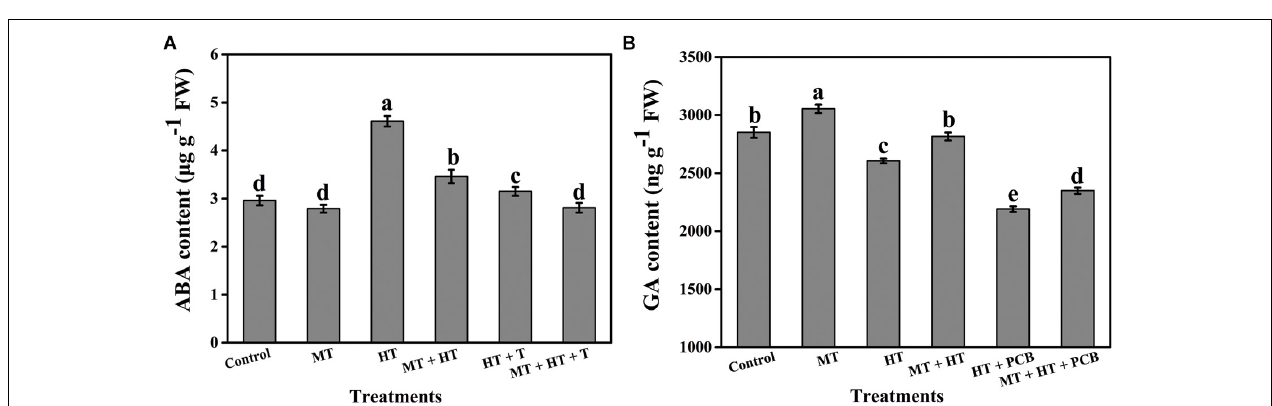
FIGURE 7 | Effects of 1 mM sodium tungstate (ST, an ABA biosynthesis inhibitor) and 1 mM paclobutrazol (PCB, a GA biosynthesis inhibitor) on the (A) endogenous ABA and (B) endogenous GA content during heat stress with or without of melatonin treatment. Different letters denote the significant variations between the treatments and the average values were measured by Tukey’s Honestly Significant Difference (HSD) test at P < 0.05. Data represented as the mean ± standard error of triplicate biological